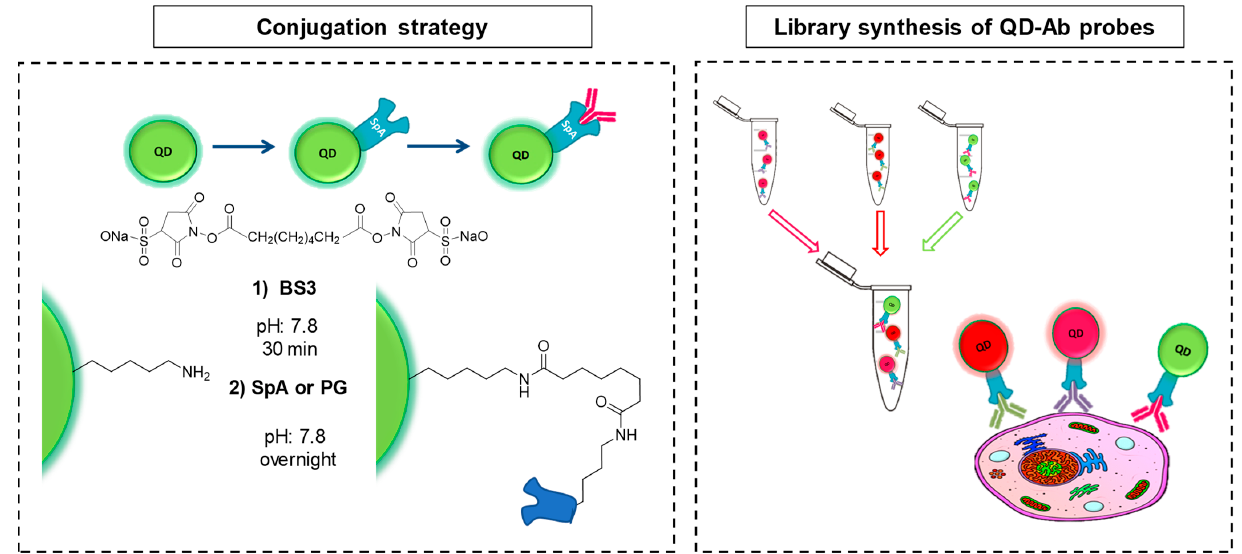
Figure 1. Bioconjugation strategy of QD-SpA or QD-PG and shematic illustration of the technology.